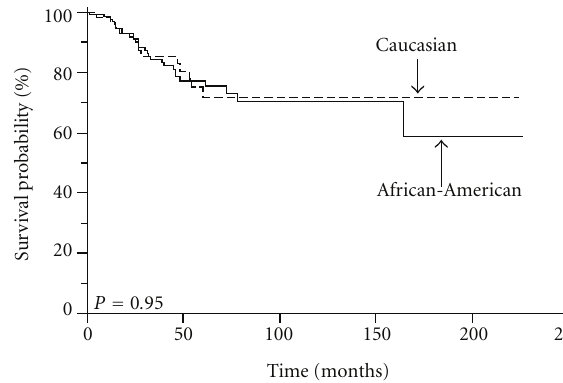
Figure 2: E ff ect of race/ethnicity on overall survival for 202 patients with triple-receptor negative breast cancer: shown is the OS for 202 African-American and Caucasian patients with TNBC as described in section 2. The 5-year OS was 77% for African-American women and 72% for Caucasian women ( P = 0 .